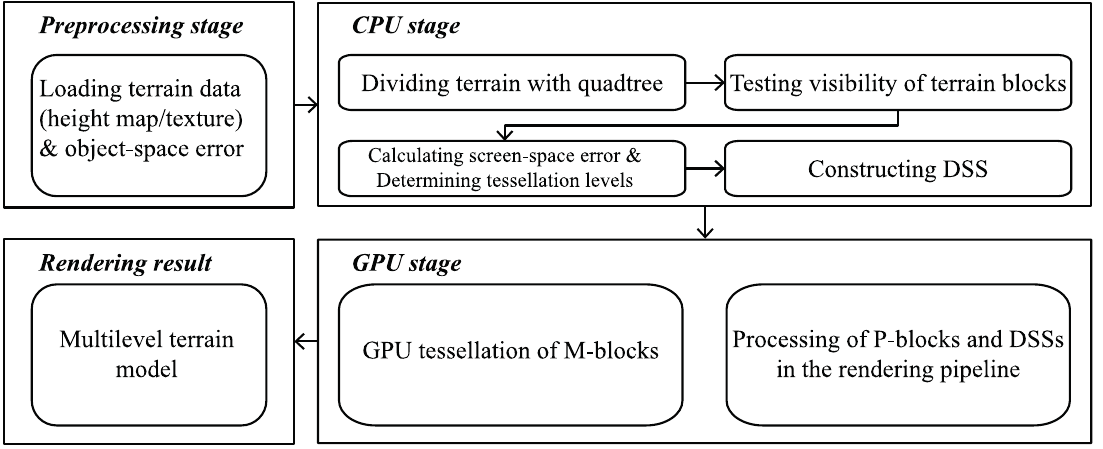
Figure 3. Flowchart of the proposed terrain rendering method.